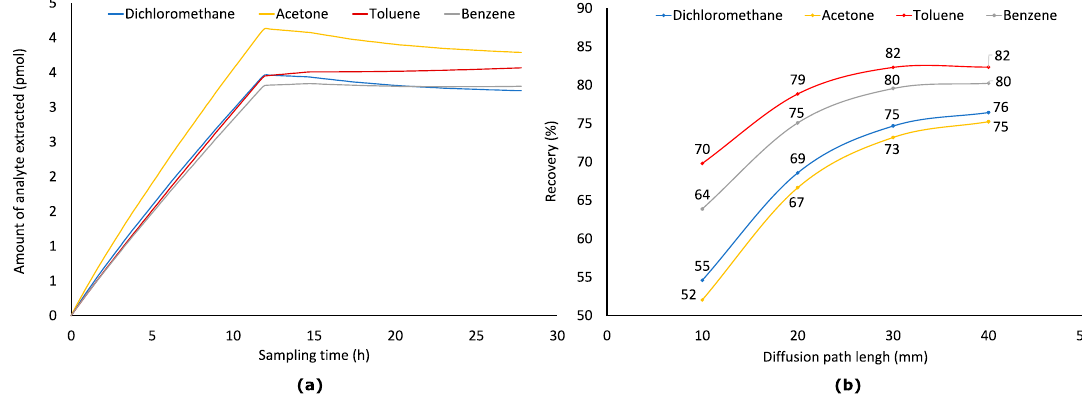
Figure 7. Sampling ( Z = 10 mm) profiles ( a ) of four analytes from air having their varying concentrations ( C 0–49,000 s = 1.176 μ mol·m − 3 , C 49,000–51,000 s = 1.176–0.1176 μ mol·m − 3 , C 51,000–100,000 s = 0.1176 μ mol·m − 3 ) and recoveries of analytes ( b ) at t = 100,000 s and different Z .